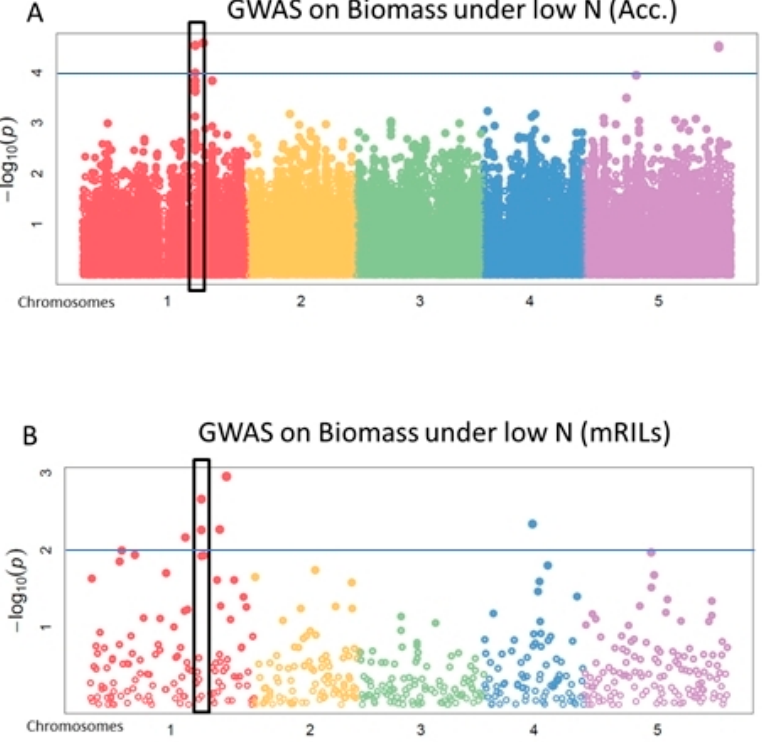
Figure 2. Identification of QTL for nitrogen use efficiency. ( A ) Manhattan blot of the genome-wide association study (GWAS) of rosette fresh weight under low nitrogen medium in 102 accessions using 100,274 SNP markers in GAPIT. Different Arabidopsis chromosomes are displayed in different colours. The box indicates the cluster of significant marker-trait associations (MTAs) on chromosome 1 (red) spanning two linked candidate genes. The horizontal line indicates the significance threshold ( p < 0.0001). ( B ) Manhattan blot of genome-wide association study (GWAS) of rosette fresh weight on low nitrogen substrate in 123 mixed recombinant inbred lines (RILs) using 536 SNP markers in GAPIT. The horizontal line indicates the significance threshold ( p < 0.01).